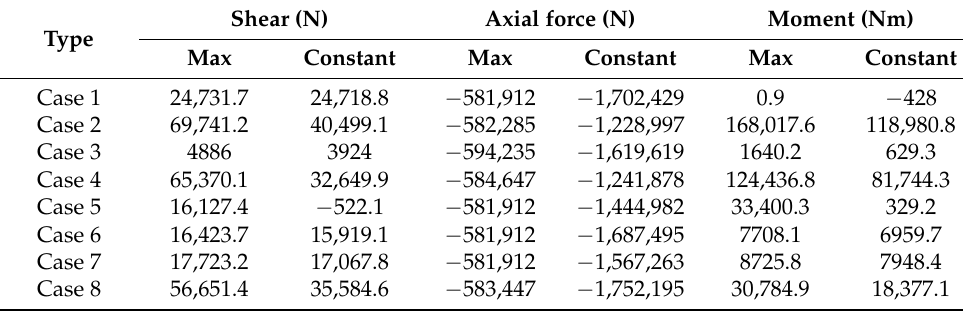
Table 7. Result force story 6 for element 58.